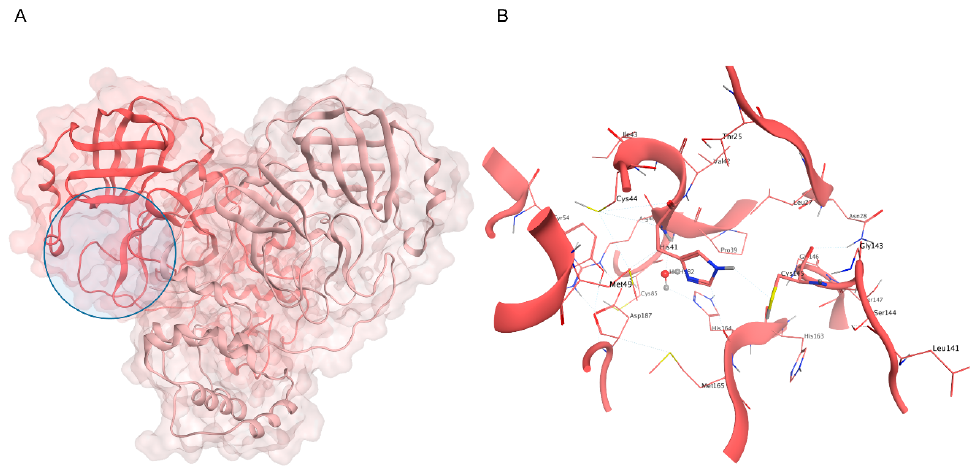
Figure 2. ( A ) Crystal structure of SARS-CoV-2 M pro (PDB ID: 6Y2E): the first protomer is colored in salmon, while the second protomer is colored in pink, and the active site position is highlighted with a blue circle. ( B ) Close-up view of the catalytic site: the H41-C145 dyad is highlighted, alongside the conserved water molecule that substitutes the third member of the canonical catalytic triad diffused in several cysteine proteases.